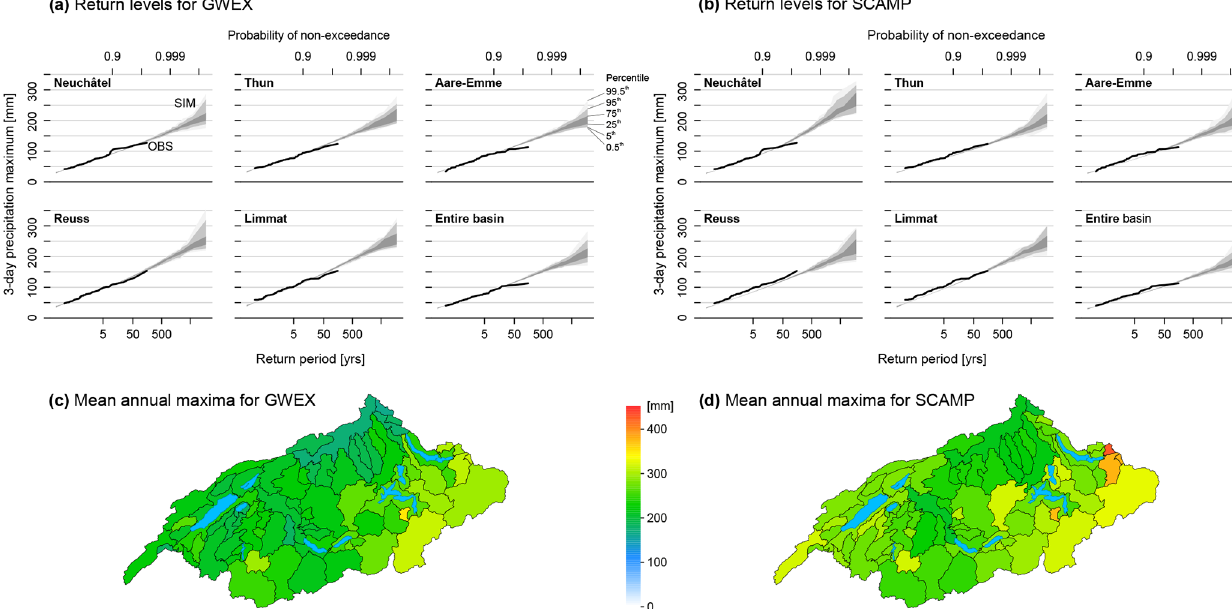
Figure 4. (a, b) Empirical return levels obtained for MAP3d (3d mean areal precipitation) from the 30 time series of 10000 years generated with GWEX (a) and SCAMP (b) for the entire Aare River basin and five main sub-regions using the Gringorten plotting position. The bounds of the grey-shaded areas correspond to the 0.5th/99.5th, 5th/95th and 25th/75th percentiles of the 30 time series, respectively. (c, d) Mean maximum simulated MAP3d from the 30 × 10000-year time series for each of the 80 HBV sub-catchments ( c : GWEX, d : SCAMP); major lakes are drawn in cyan. Note that the largest simulated MAP value in one 10000-year-long simulation corresponds to a return period of 18000 years (Gringorten plotting position). Also note that the extreme MAP values mapped do not necessarily occur simultaneously, i.e. do not correspond to one single